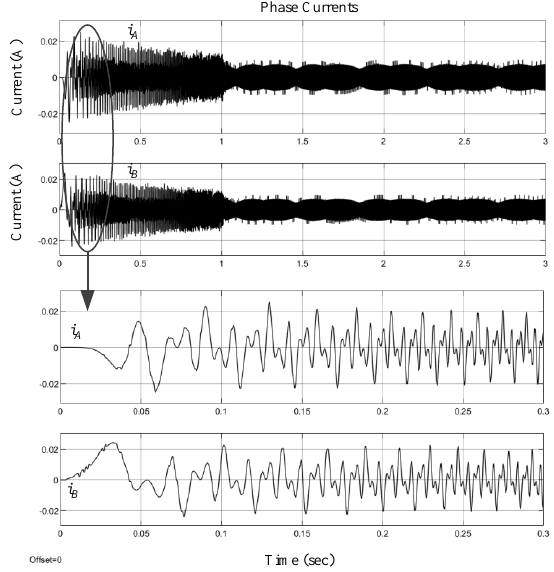
Figure 10. The simulated stator current responses for the speed command of 31.4 rad/s.